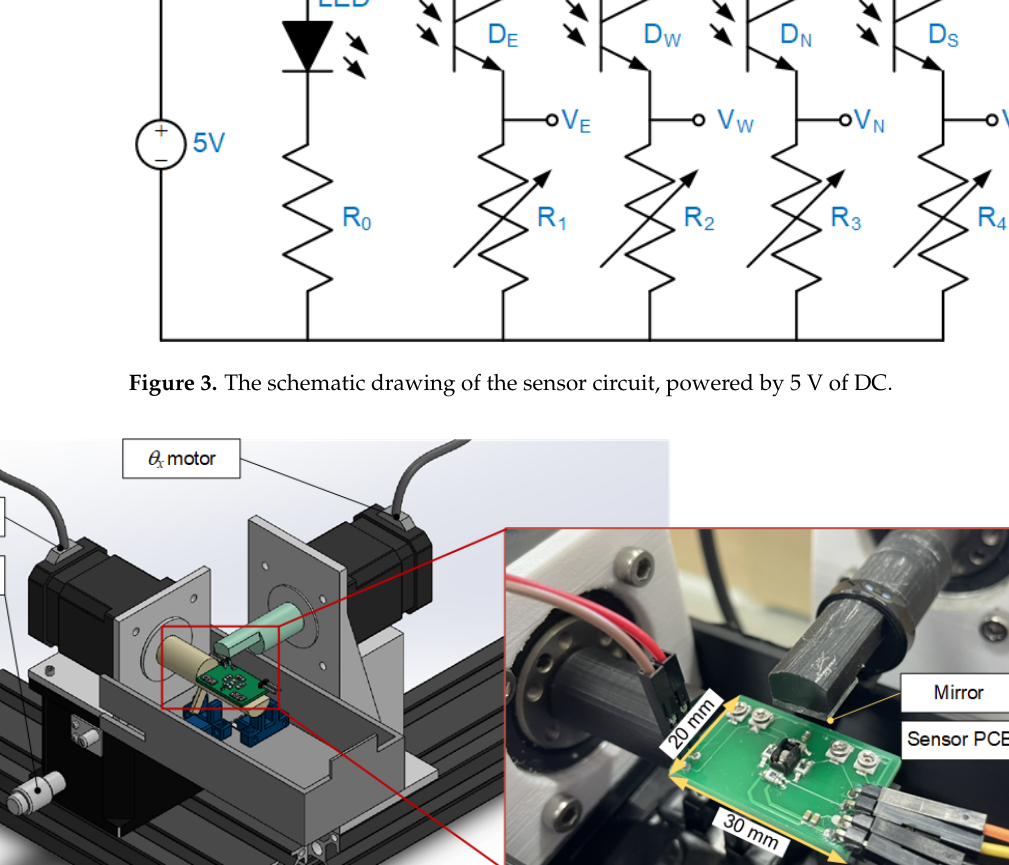
Figure 4. Test-bench consisting of two motor-driven shafts and a translational z-stage.